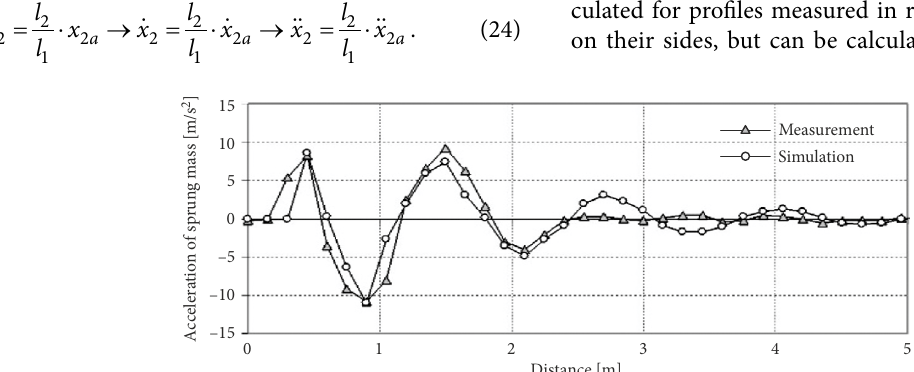
Figure 4. Comparison of measured and simulated dynamic response of sprung mass of JP VSDS initiated by speed control bump (see Figure 2, on the